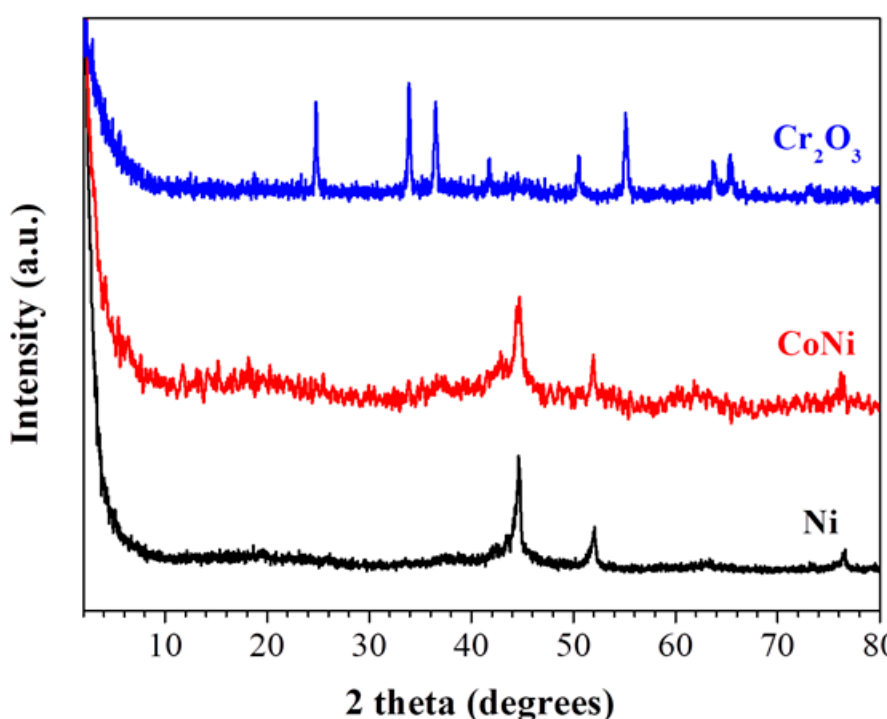
Figure 11. XRD patterns of the as-derived Ni, CoNi alloy, and Cr 2 O 3 nanoparticles.